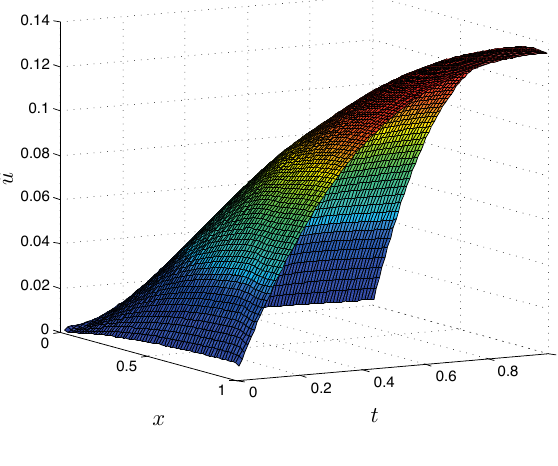
Fig. 6. Plot of the numerical solution for Test Problem 8